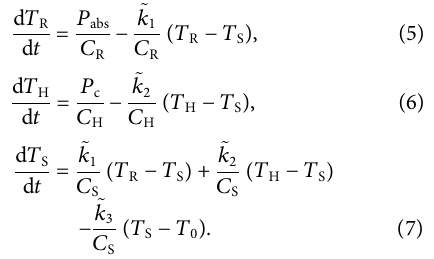
physically distant from the microheater, the substrate and the heat sink. Each of them is characterized by a temperature, labeled T R , T H , T S and T 0 , respectively. Here, T R and T H are the local temperatures, while T S is a global temperature which rules the global thermal fl ux. Our simple theoretical model is based on the heat exchange between these four blocks. The propagation of